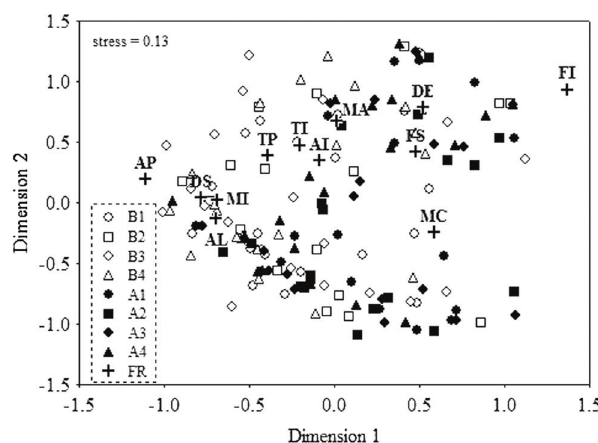
Fig. 2. Graphical representation of the first two axes of the Nonmetric multidimensional scaling (nNMDS), demonstrat- ing the food resources used by the fish fauna in the different sites and phases, in the area influenced by the Salto Caxias Reservoir, Iguaçu River. FR = Food resources (AI = aquatic insects; TI = terrestrial insects; DE = decapods; MC = micro- crustaceans; MA = macroinvertebrates; MI = microinverte- brates; FI = fish; FS = fish scales; AP = aquatic plants; TP = terrestrial plants; AL = algae; DS = detrit/sediment); B = before impoundment, A = after impoundment; 1 to 4 = sampling